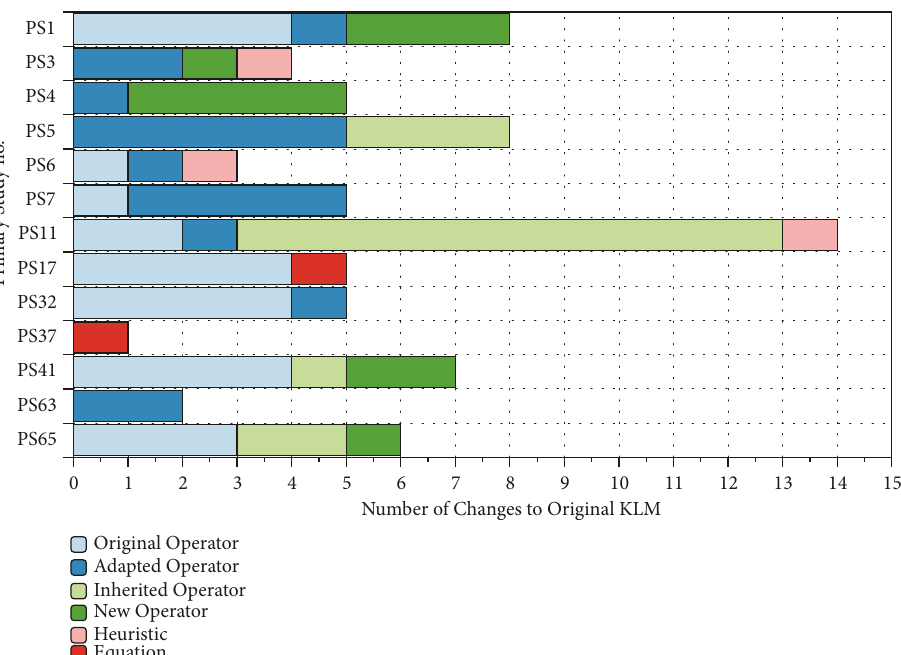
Figure 8: The number of original operators preserved, adapted, inherited from other extensions or prior literature, and newly introduced in the traditional setups